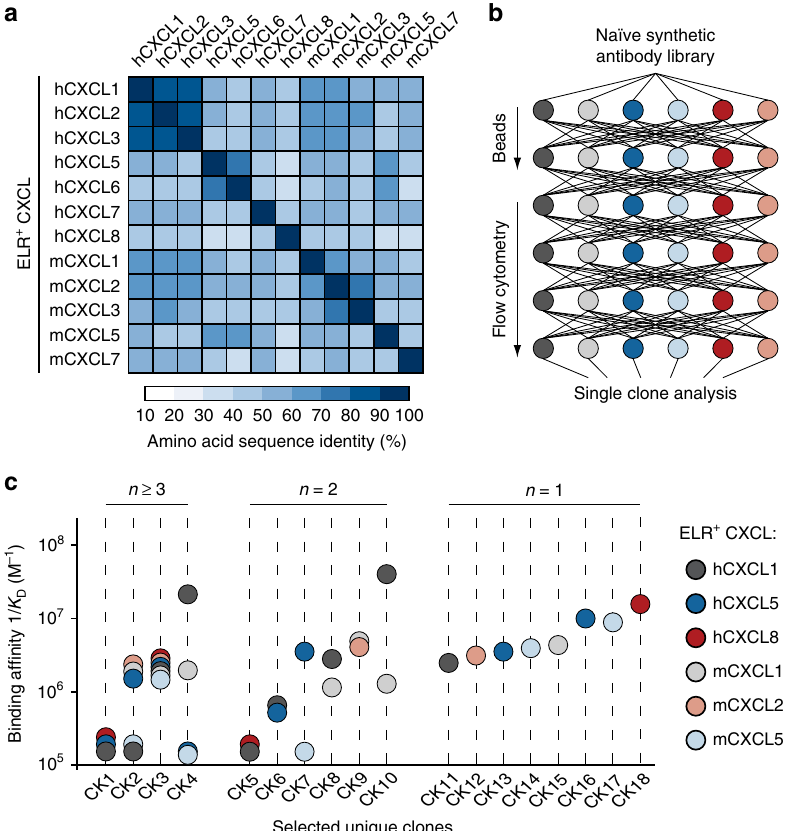
Fig. 1 Isolation of crossreactive antibodies toward multiple ELR + CXC chemokines. a Heat map displaying the sequence identity among multiple human and murine ELR + CXC chemokines. The color of each element in the heat map indicates the sequence identity percentage, ranging from 10% (white) to 100% (dark blue). “ h ” and “ m ” indicates human and murine CXC chemokines, respectively. b Schematic representation of the iterative selection pathways applied to isolate crossreactive molecules from a naïve library of synthetic antibodies displayed on the surface of yeast. Two cycles of magnetic bead screening followed by four cycles of fl ow cytometry sorting were applied. c Plot of the binding af fi nities of 18 unique yeast-displayed synthetic antibody protein binders (CK) selected using six diverse human (hCXCL1, hCXCL5, and hCXCL8) and murine (mCXCL1, mCXCL2, and mCXCL5) ELR + CXC chemokine ligands. Each chemokine and its corresponding binding af fi nity values are reported as differently colored fi lled circles and indicate the means of at least three independent experiments. Data are presented as inverse equilibrium binding constants (1/ K D ; M − 1